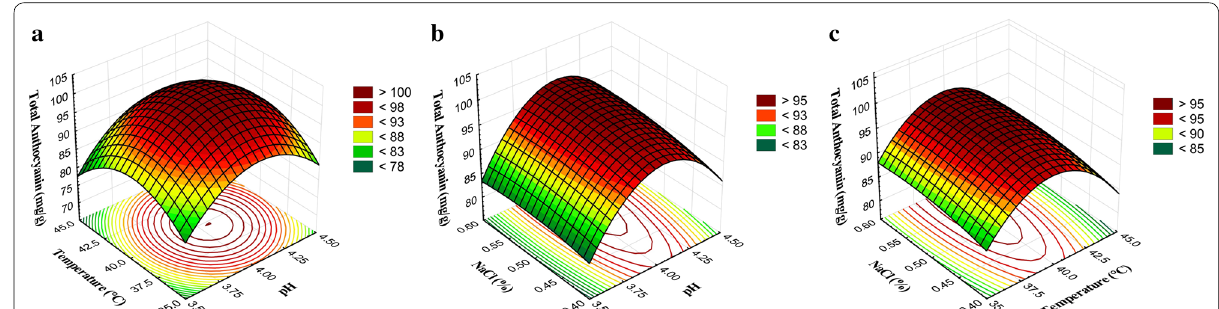
Fig. 1 Response surface plot for the total ACN content of FRB describing the interaction of independent variables namely, pH, temperature, and NaCl concentration on ACN content. a Effect of temperature and pH on total ACN content of FRB, b effect of NaCl concentration (%) and pH on total ACN content of FRB, and c effect of NaCl concentration (%) and temperature on total ACN content of FRB